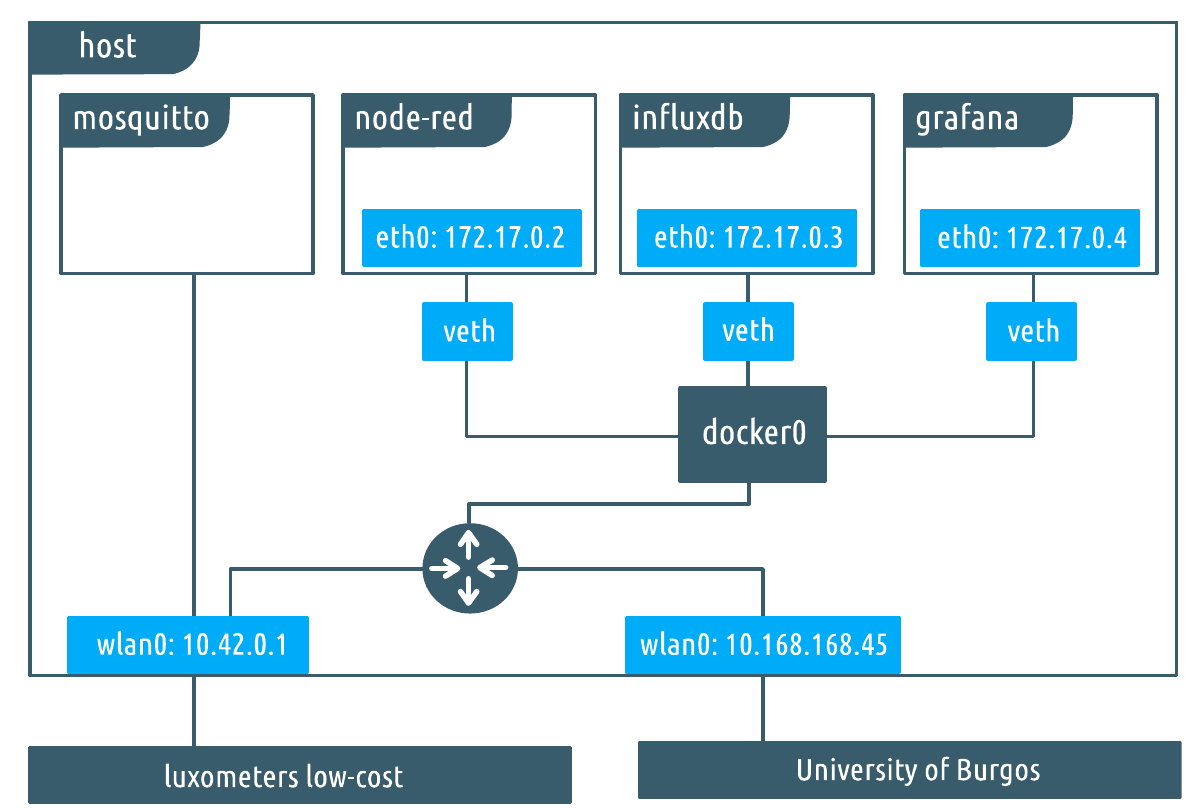
Figure 7. Detailed diagram of the containers’ infrastructure.